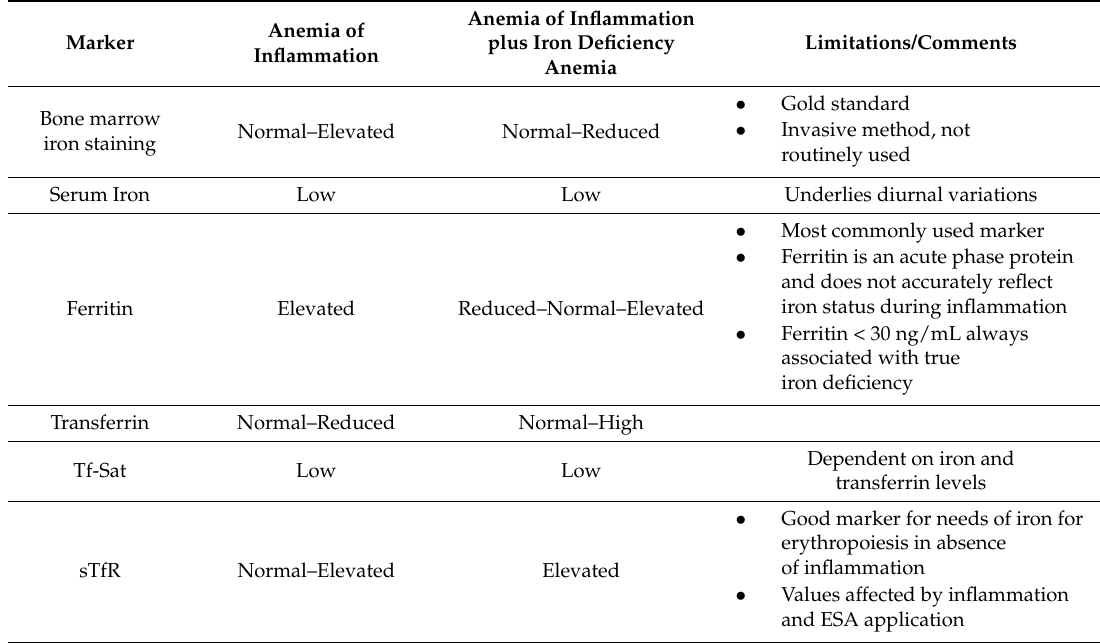
Table 1. Diagnostic markers for the diagnosis of different types of inflammatory anemia.